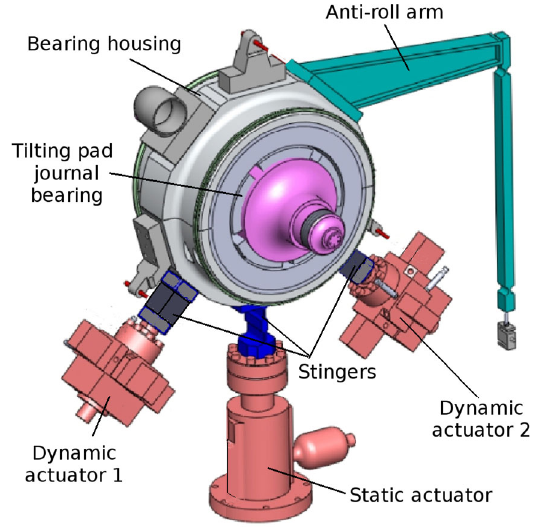
Fig. 3 3D schematic of test zone of tilting pad journal bearing rig showing load application